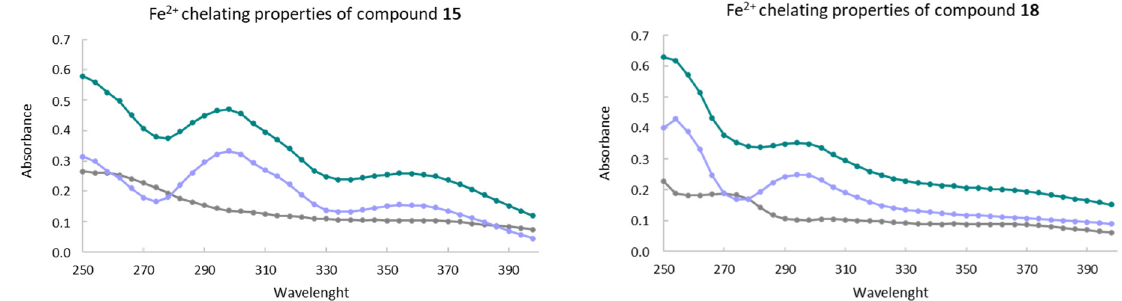
Figure 5. Fe 2+ chelating properties of compounds 15 and 18 presented as a shift of absorbance (violet) between the absorbance of the ligand—Fe 2+ mixture (green) and a sum of the absorbance of the ligand and Fe 2+ (grey) at 50 µ M concentration of ligand and Fe 2+ .